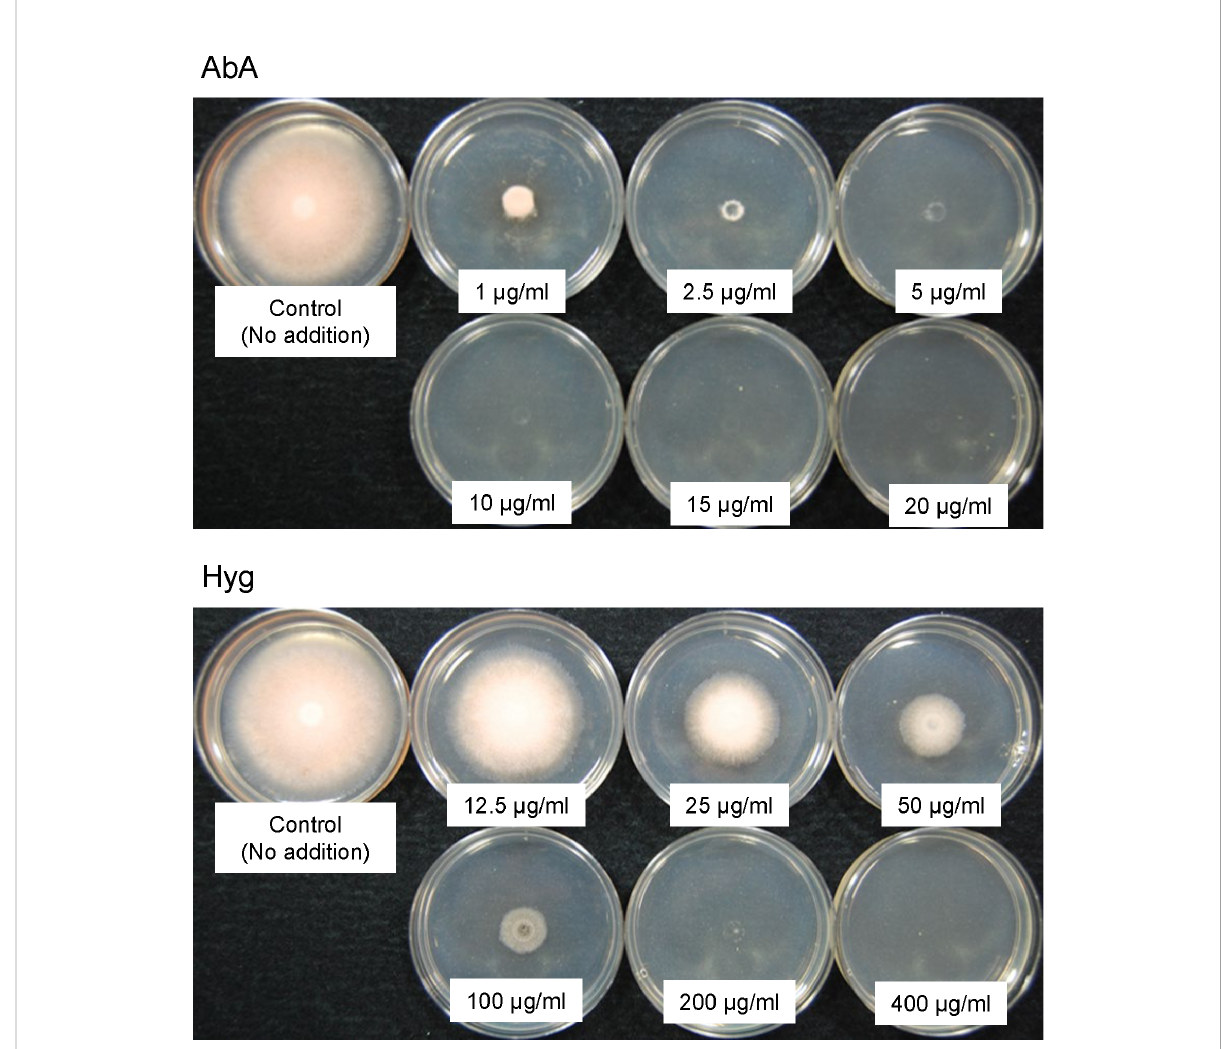
FIGURE 5 The susceptibility of the Curvularia clavata BAUA-2787 protoplast to aureobasidin A (AbA) and hygromycin (Hyg). The concentration of each agent in the medium is shown in the